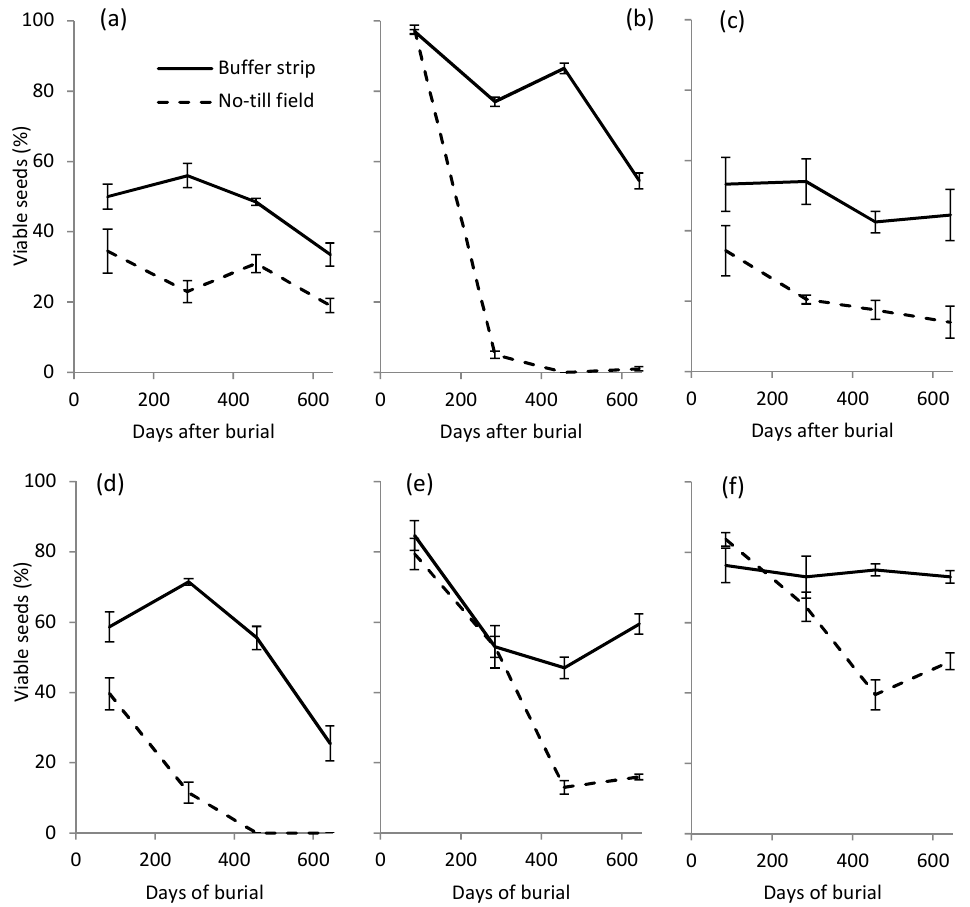
Figure 2. Percentage of viable seeds after different days of burial in the soil of the NT field and vegetated BS. ( a ) A. theophrasti ; ( b ) A. myosuroides ; ( c ) A. retroflexus ; ( d ) D. sanguinalis ; ( e ) P. oleracea ; ( f ) S. halepense .